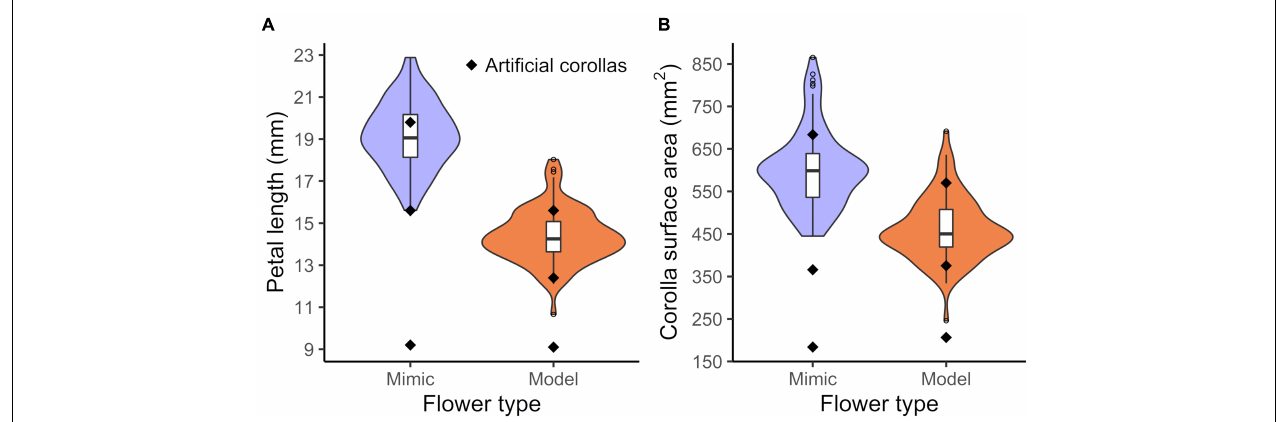
FIGURE 3 | Variation in petal length and corolla surface area of Begonia odorata model (male) and mimic (female) flowers and corresponding measurements of artificial corollas. Boxplots of variation in mimic and model (A) mean petal length per flower and (B) corolla surface area. Artificial corollas (black diamonds) and distribution for the live flowers (violin plots) are also plotted. The artificial corollas were modeled on flowers growing prior to the COVID-19 lockdown—the lockdown delayed measuring a complete distribution of flowers and it appears the distribution of sizes subsequently shifted and narrowed. N = 84 and 86 mimic and model flowers,